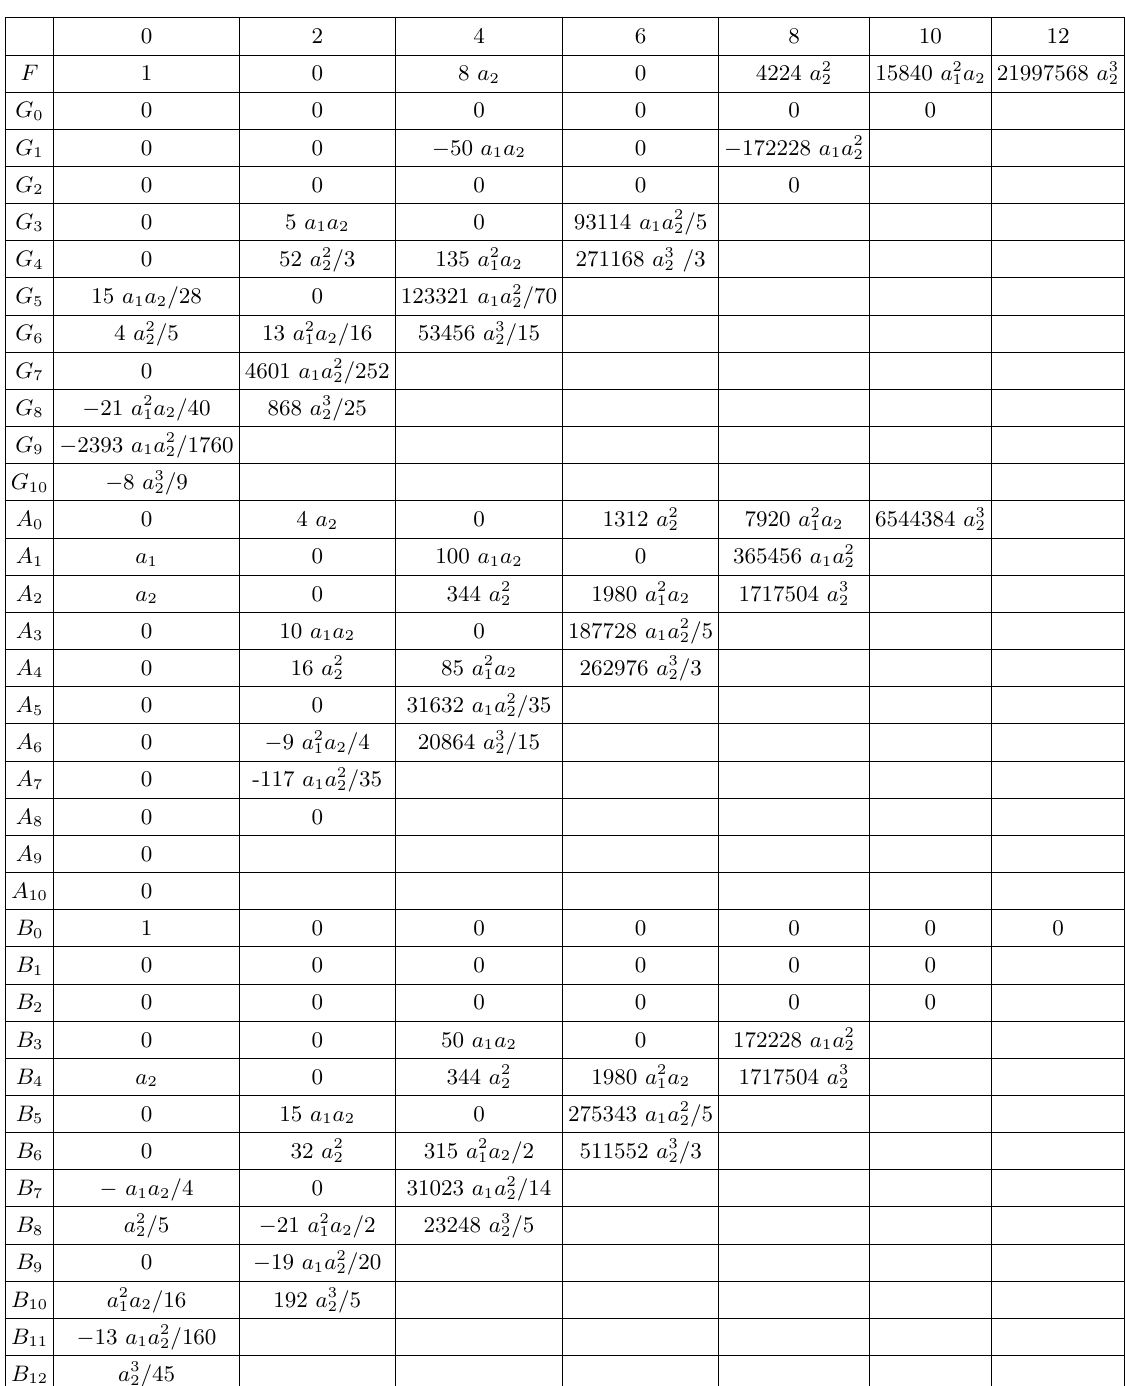
Table 1. Time derivatives of the solution (2.6) at t = 0. The number of time derivatives is listed at the top of each